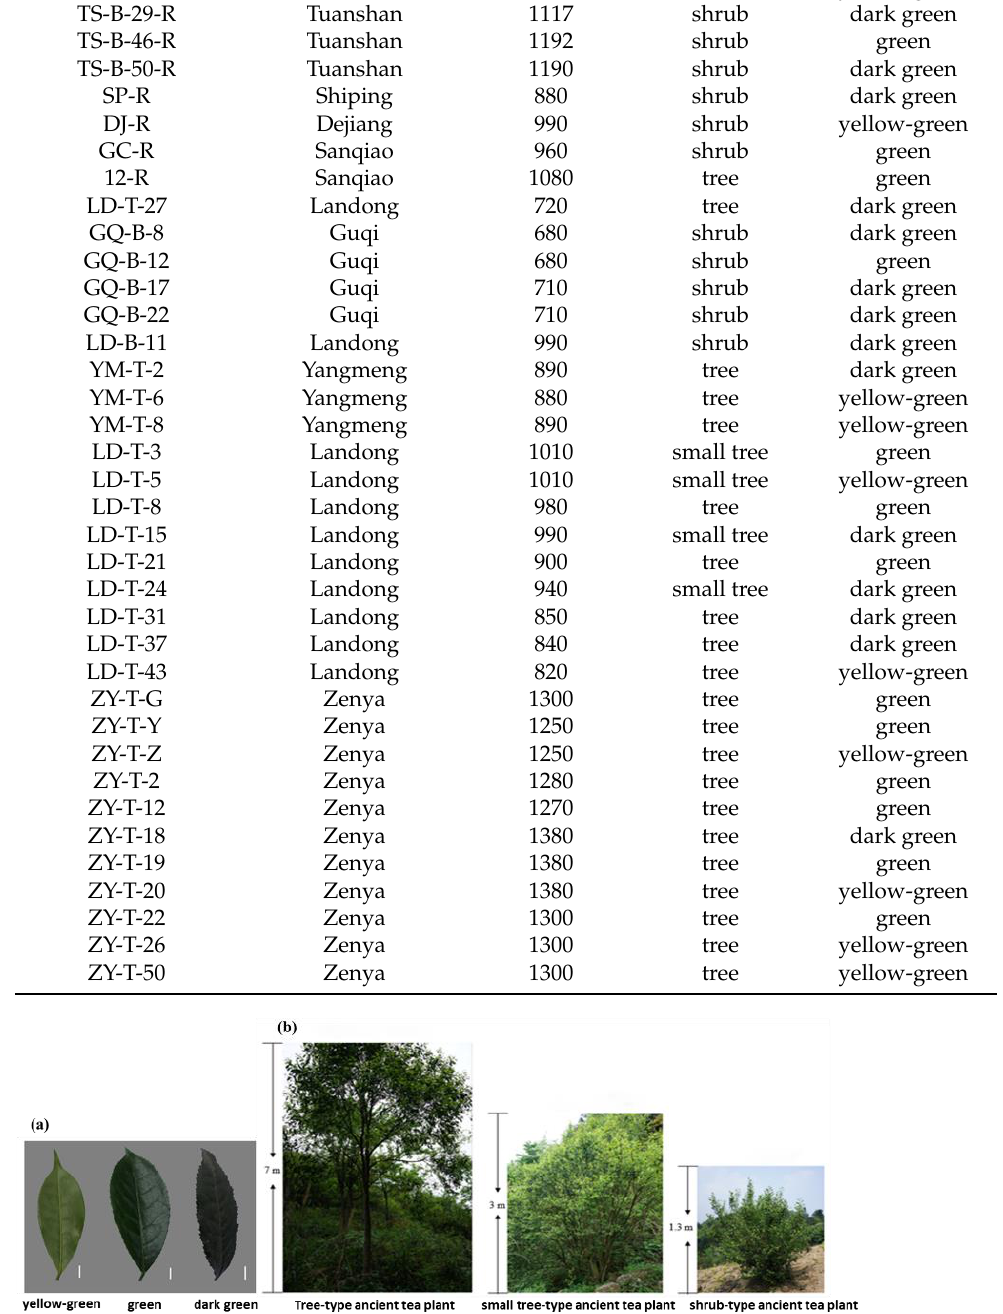
Figure 1. Leaf color and tree shape of ancient tea plants. ( a ) The leaf colors of 125 ancient tea plants were categorized into yellow-green, green, and dark green. ( b ) The tree shapes included tree, small tree, and shrub types.